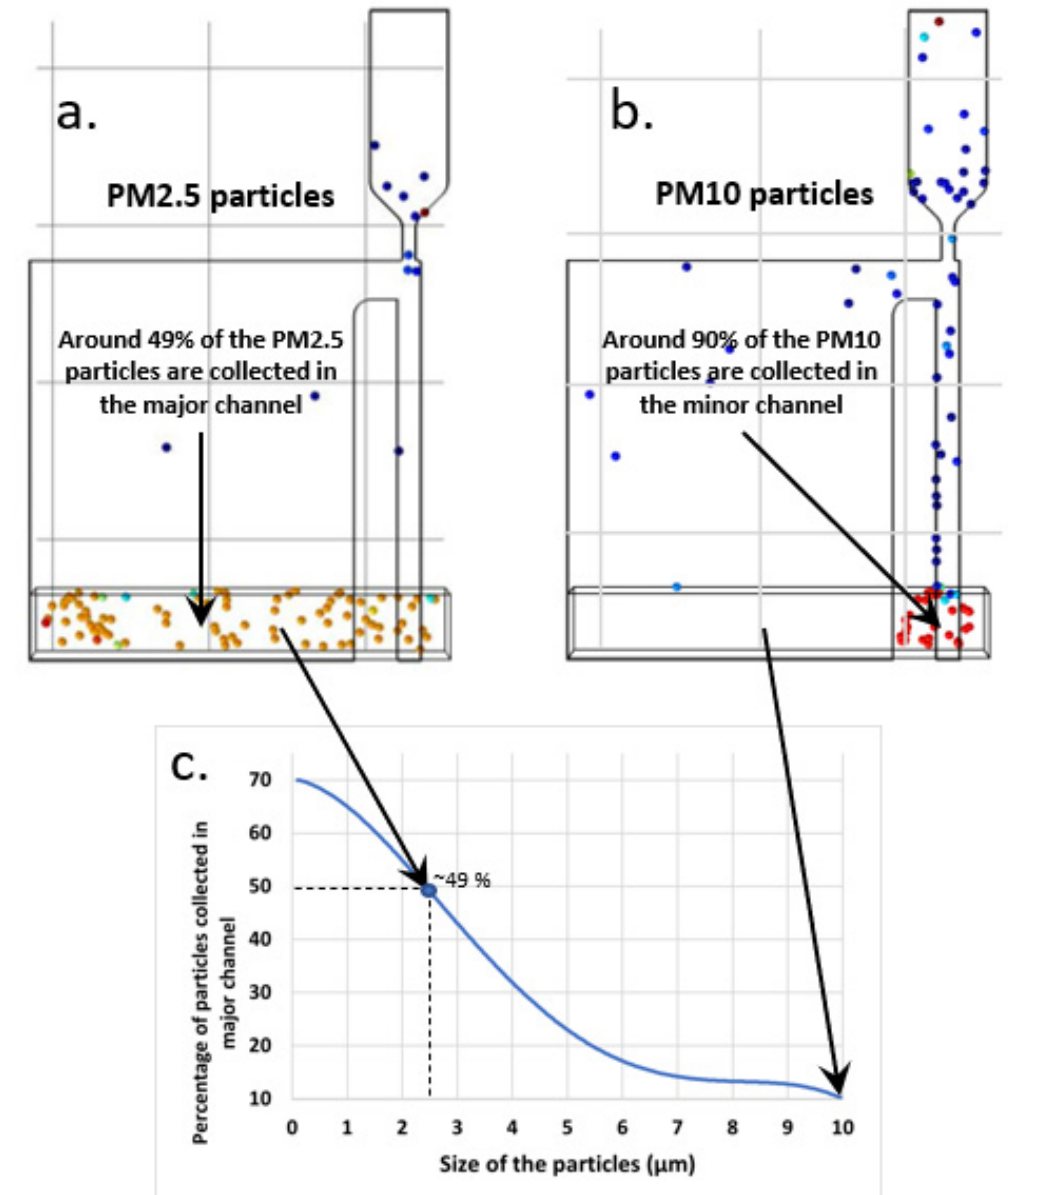
Figure 7. COMSOL simulation results for collection efficiency of ( a ) PM2.5 and ( b ) PM10 particles. ( a ) Shows that around 49% of the PM2.5 particles are collected in the major channel and ( b ) depicts that only about 10% of the PM10 particles are collected in the minor channel. ( c ) presents the collection efficiency of the virtual impactor for a range of particle sizes. The figure shows the percentage of the total particles collected in the major channel of the virtual impactor.